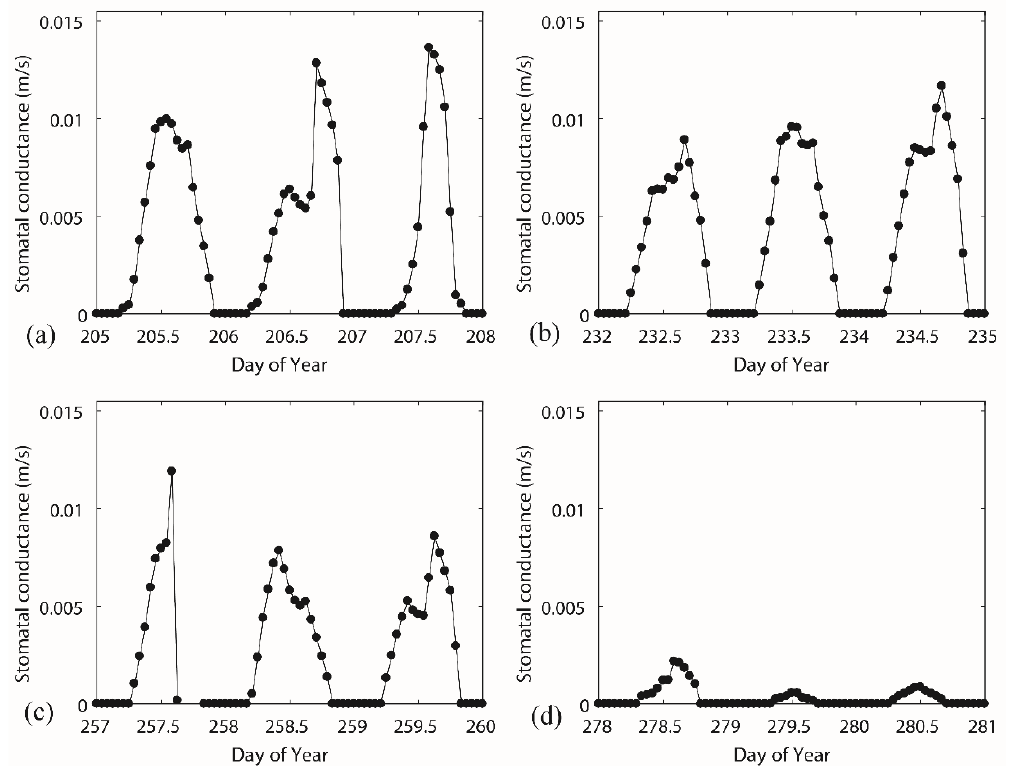
Figure 6. Canopy conductance inversely calculated from the Penman–Monteith equation over four selected periods, including ( a ) DOY 205–DOY208, ( b ) DOY 232–DOY 235, ( c ) DOY 257– DOY 260, and ( d ) DOY 278–DOY 281, which were covering from the vegetative period to the deciduous period.